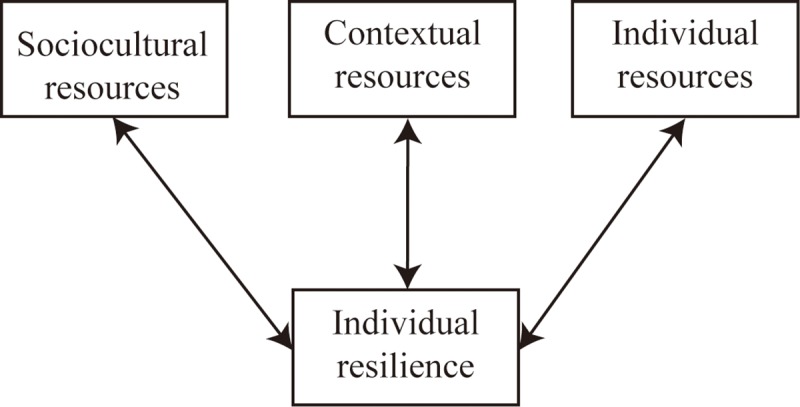
Framework of the Resilience Scale.